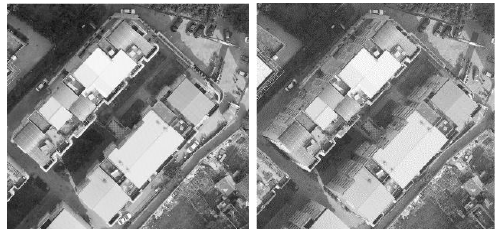
Fig. 7. Patch #1 - Image size are 1406*1497 pixels and